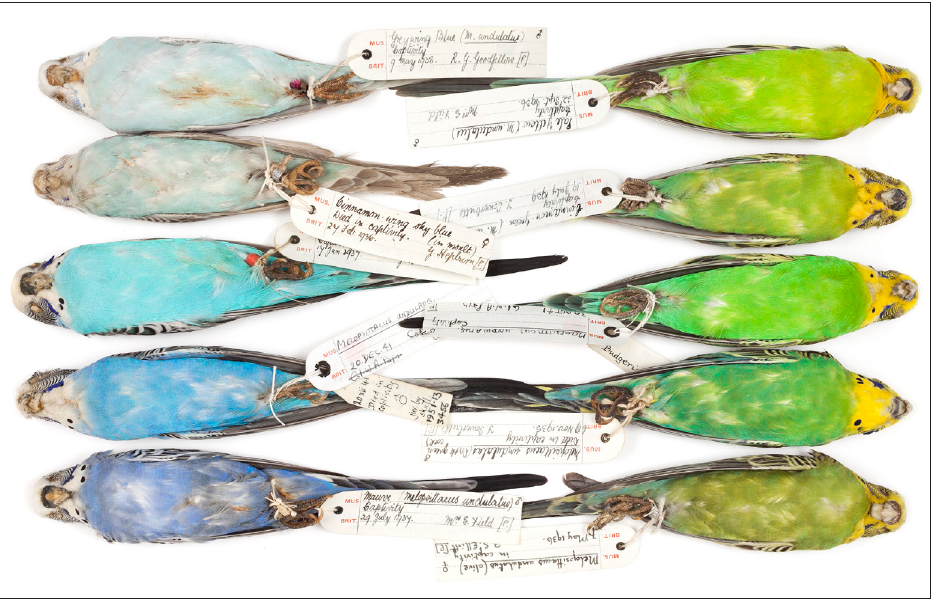
Figure 1: Budgie specimens illustrating colour variations: Budgie specimens illustrating colour variations © Trustees of the Natural History Museum.